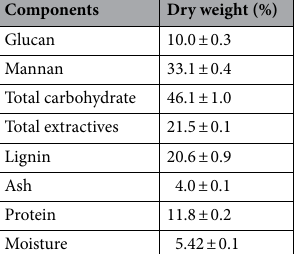
Table 5. Chemical composition of the raw